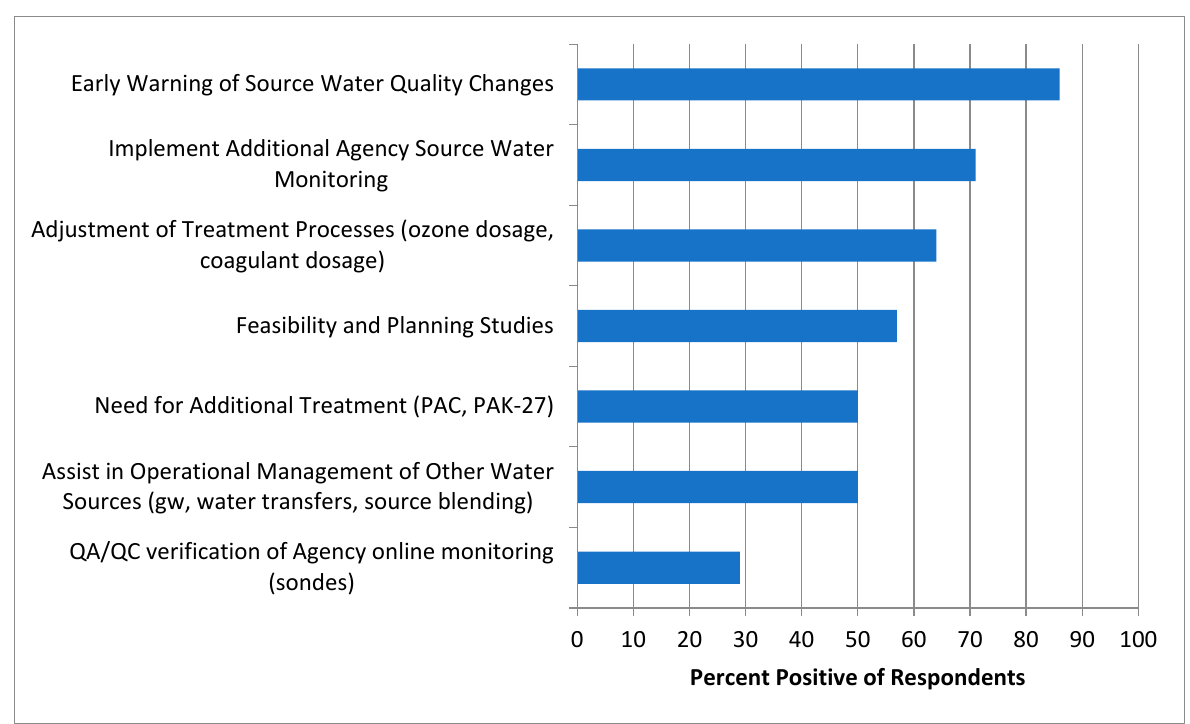
Figure A3. Survey results from 14 water contractors on how they use MWQI real time and forecast data in their regular operations. Table A1. SWP Watershed Sanitary